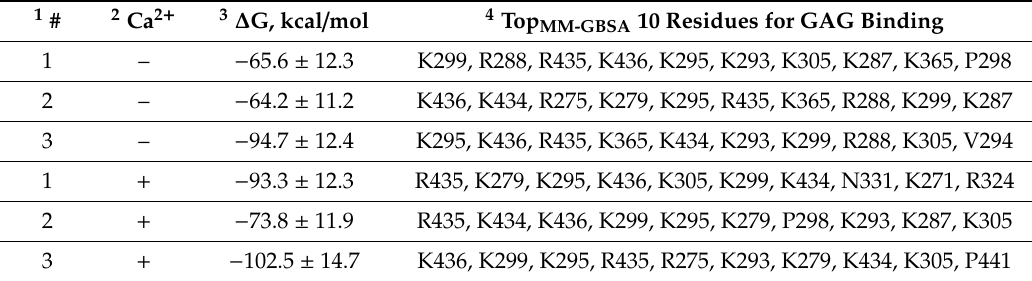
Table 10. Fragment-based molecular docking MD analysis summary for PCPE-1 SAXS Model / Ca 2 + / HP dp11